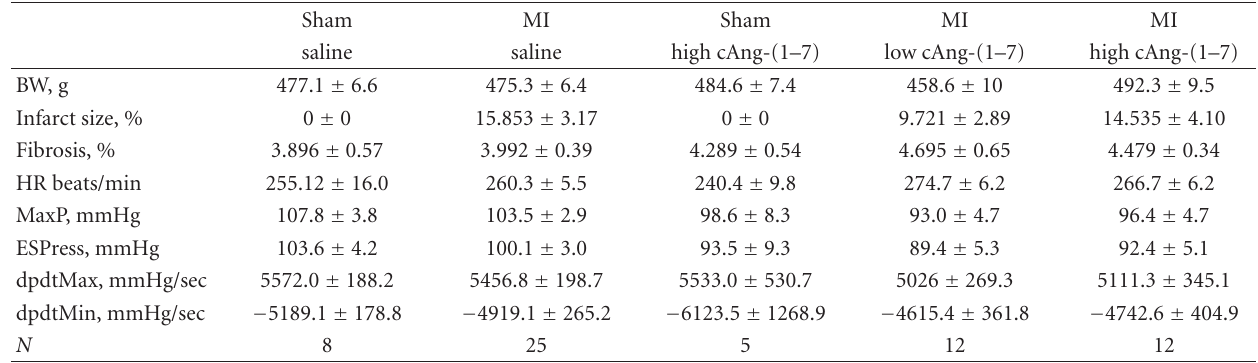
Table 1: Weight, basic histological and cardiac